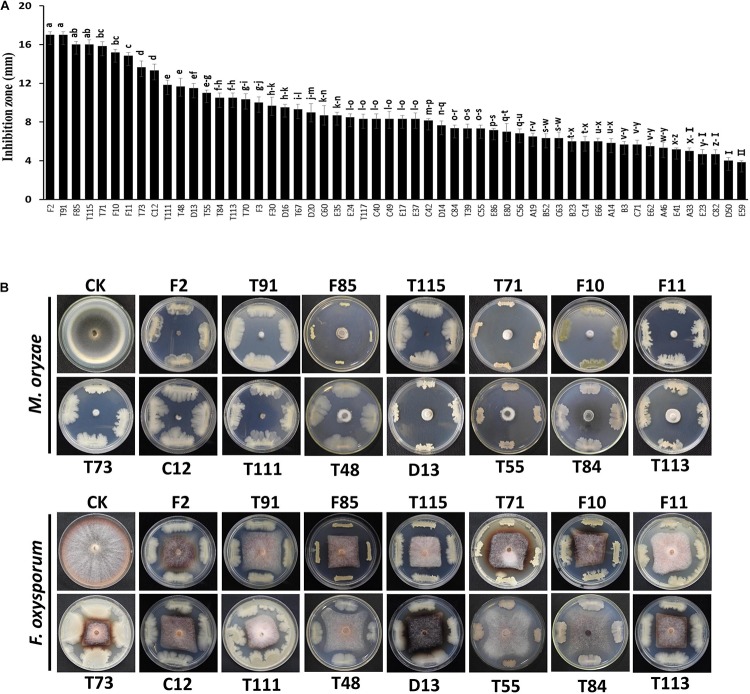
Streak plate method to screen antagonistic strains by using indicator fungi, Fusarium oxysporum and Magnaporthe oryzae. (A) Average size of inhibition zones of the two indicator fungi. Each experiment was repeated three times. (B) Inhibition zones of biocontrol strains against the two fungi. The red line indicated the inhibition zones greater than 10 mm as the cut-off value. Data are presented as mean ± SD. Different letters indicate significant differences between treatments according to LSD test (P < 0.05). Capped lines represent standard errors.